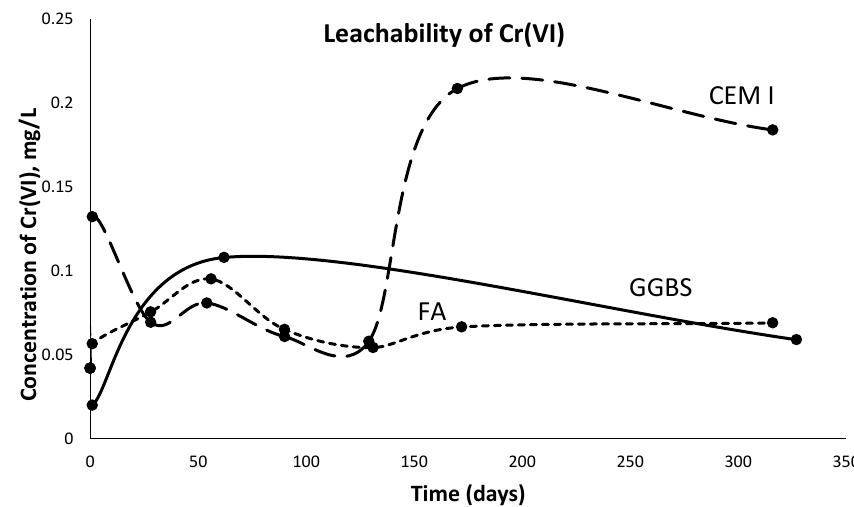
Figure 6. Concentrations of Cr(VI) leached from CEM1, GGBS and FA adsorbents.